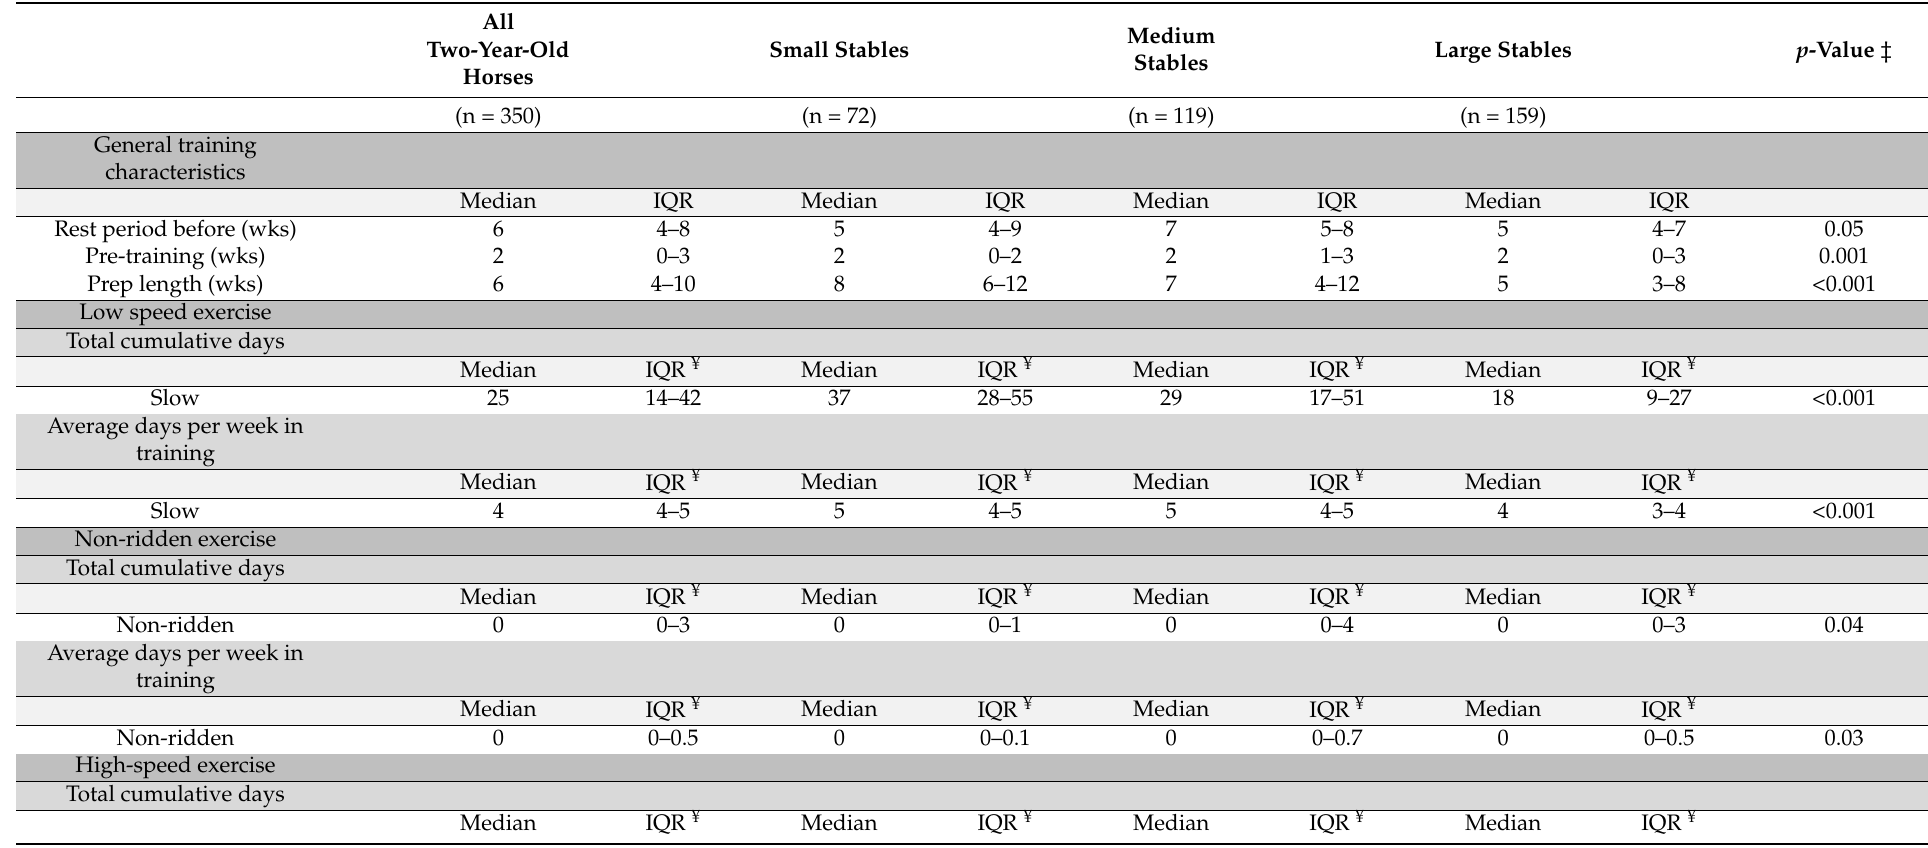
Large Stables p -Value